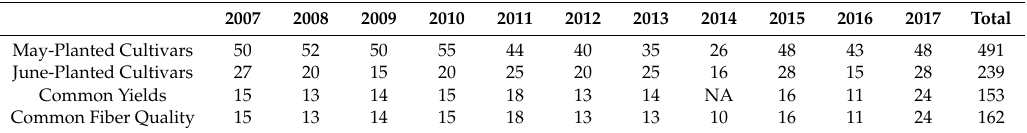
Table 2. Total number of cultivars planted on Table 1’s May and June planting dates. Common counts indicate the number of possible yield and fiber quality comparisons during each year. ‘NA’ indicates years when data was not available.